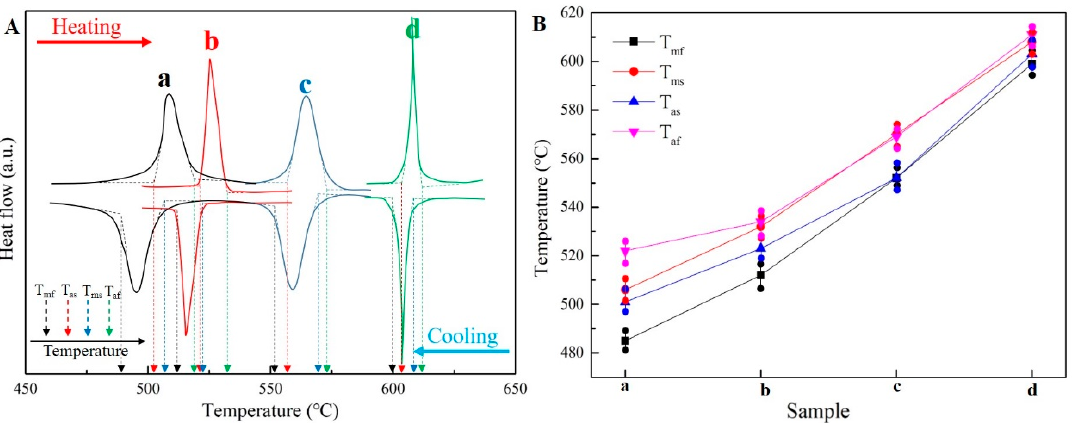
Figure 4. DSC curves ( A , (a) Sample a; (b) Sample b; (c) Sample c; (d) Sample d) plotting heat flow as a function of temperature and phase transition temperature ( B ) for samples in different hot-magnetic drawing conditions.